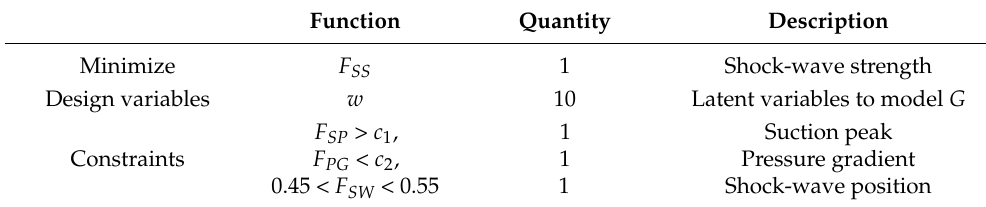
Table 4. Optimization problem statement for different inverse design requirements.